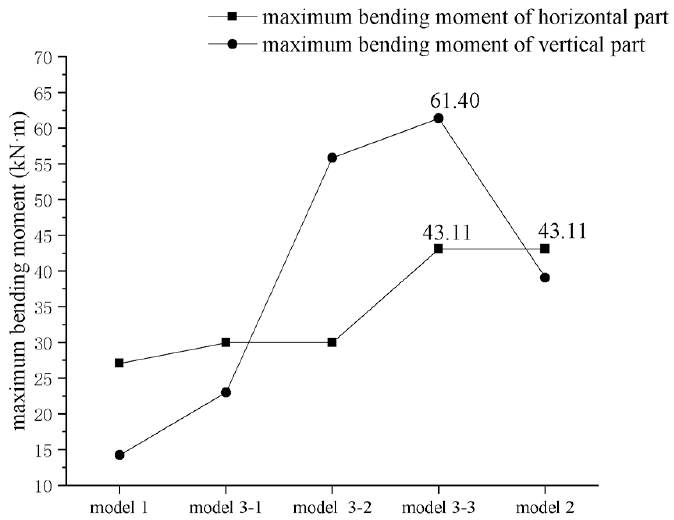
Figure 20. Maximum bending moments of the horizontal part and vertical part for the L-shaped components in each model.